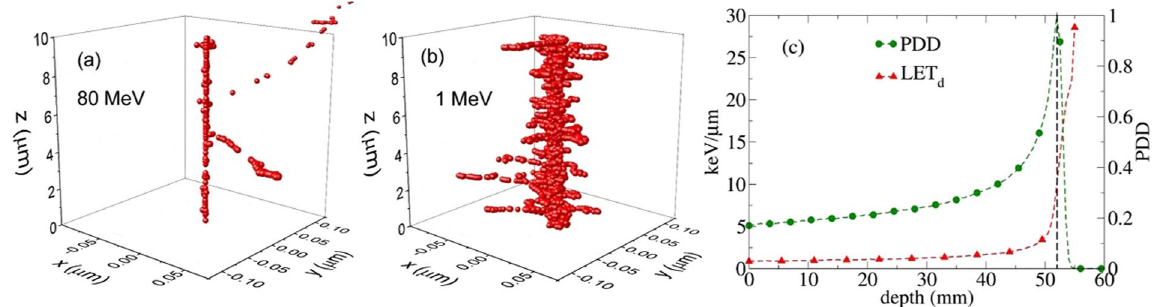
Figure 1. Two ionization-tracks of 80 MeV ( a ) and 1 MeV (b) protons obtained from the Geant4-DNA Monte Carlo simulation in water with initial points at x = y = z = 0 and directions parallel to z axis. The number of events in 1 MeV proton is one order of magnitude greater than 80 MeV. Such compact ionization events in low energies clearly justify a deviation from Poisson distribution that may describe the ionization in 80 MeV. The relative energy deposition along Bragg curve and LET for a beam of proton with 80 MeV is shown in ( c ). The line indicates the position of Bragg peak at approximate 5.2 cm depth corresponding with LET ≈ 10 keV / μ m .